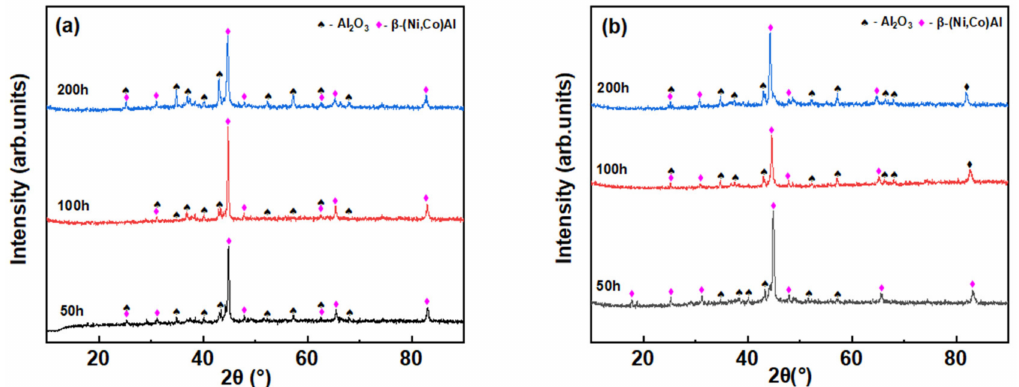
Figure 4. XRD patterns of samples E1 ( a ) and E2 ( b ) after hot salt-water corrosion